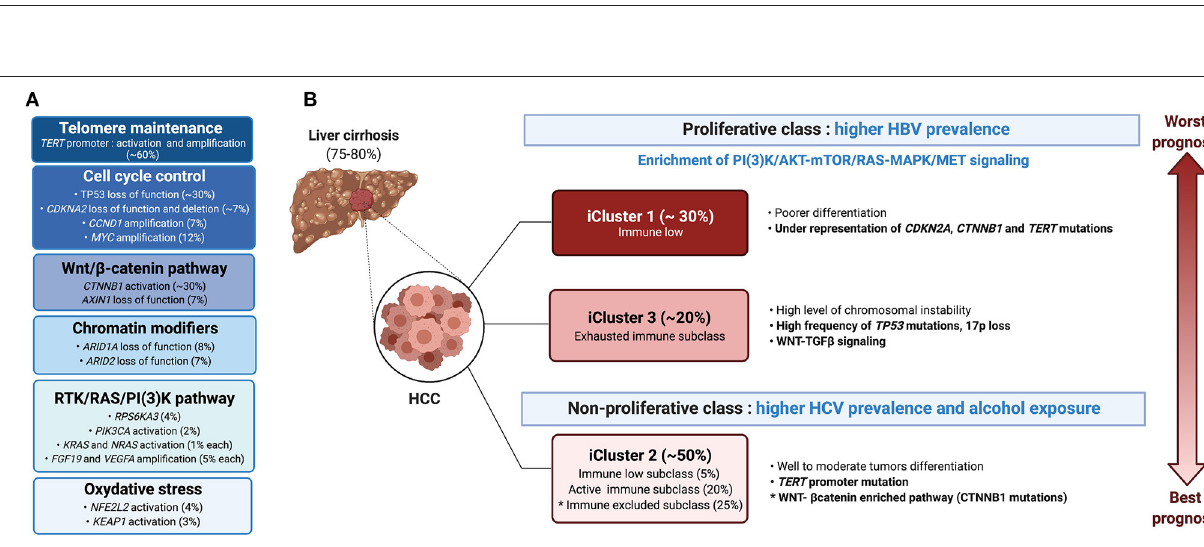
FIGURE 4 | Molecular and immunological classifications of HCC. (A) The main oncogenic events associated with HCC are presented in descending order of incidence, the most common being defects in telomere maintenance, followed by alterations in cell cycle control, and activation of the WNT/ β -catenin pathway. (B) Based on molecular features, HCC patients can be grouped into either the proliferative or non-proliferative class, the first with higher prevalence of HBV infection and a bad prognosis, whereas the second including cases with HCV infection or alcohol abuse and having a better prognosis. Integration of genomic, expression and epigenetic data by the TCGA research network ( 32) identified a different classification, namely iClusters 1-3. iCluster 2 which represents 50% of the patients and is related to the non-proliferative class, includes three sub-classes: an “active immune subclass,” an “immune excluded” subclass and an “immune low” subclass. An “immune exhausted” subclass is found within iCluster 3 of the proliferative class, whereas iCluster 1 is characterized by an “immune low”